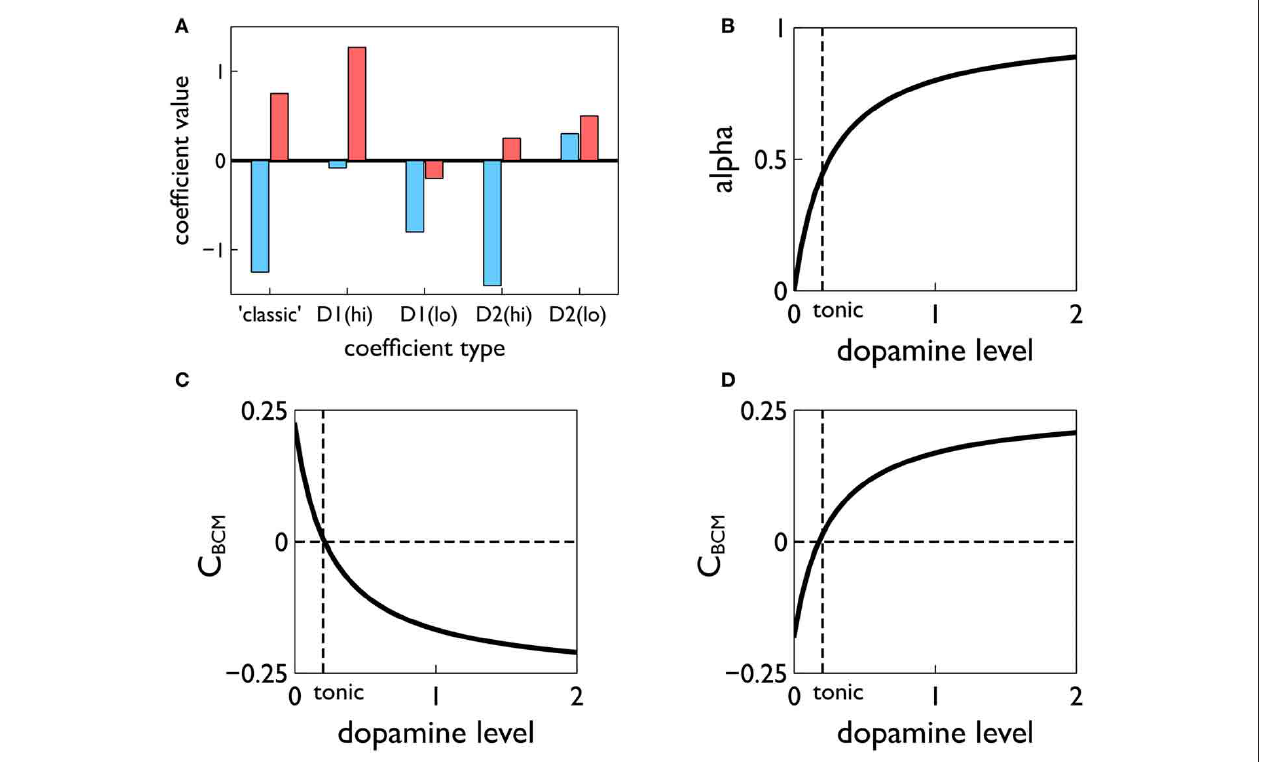
FIGURE 7 | Construction of the learning rule. (A) The plasticity coefficients consistent with the data of Shen et al. (2008). (B) The dopamine mixing function α ( d ) defined in Equation (11). (C,D) The dopamine-dependent versions of the factors C BCM in Equation (10) for D1 and D2-MSNs, respectively.